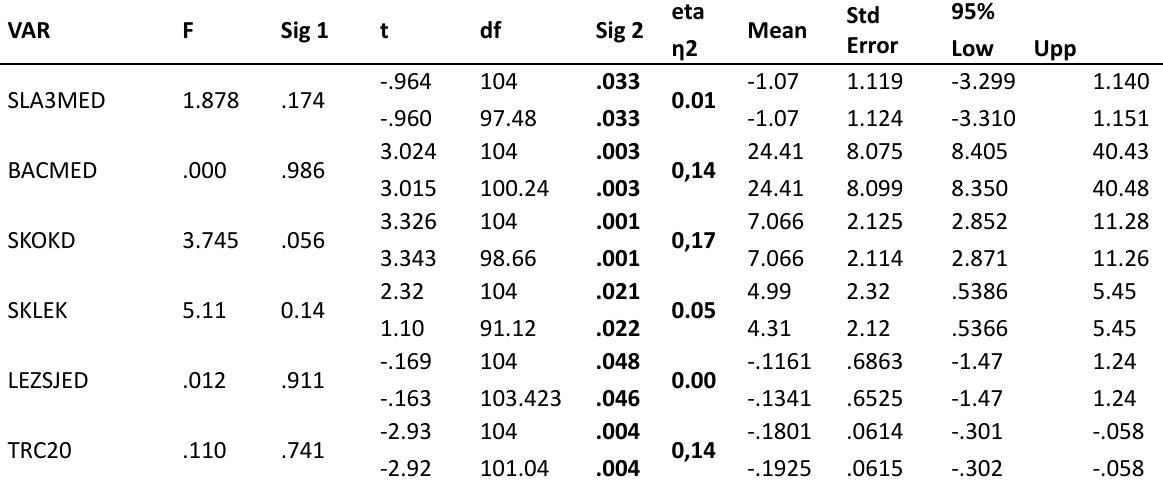
95% eta Std Mean Error Upp η2